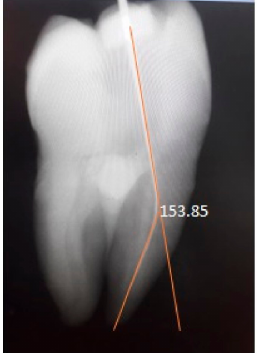
Figure 3. Image Shows the X-ray taken as routine mesial angulation with measured canal curvature (180 ◦ − 153.85 ◦ = 26.15 ◦ ) by Schneiders technique.